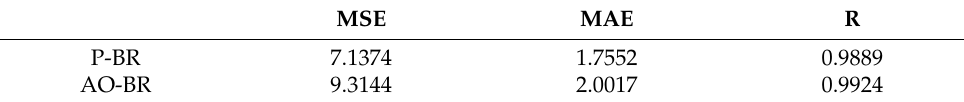
Table 11. Evaluation metrics for test set of the P-BR and the AO-BR. MSE